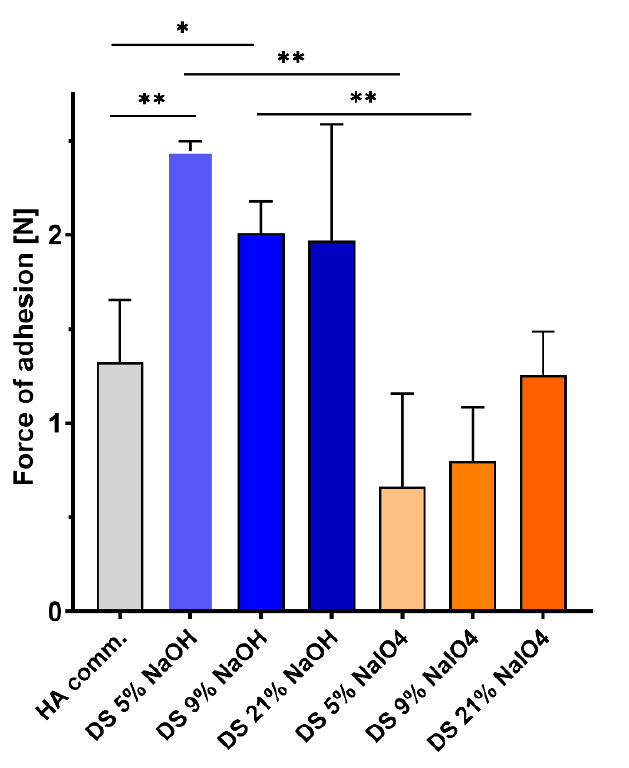
Figure 6. Adhesive properties of HA-Dop gels. Statistical analysis: unpaired t -tests. * p = 0.04, ** p = 0.003, n = 3.